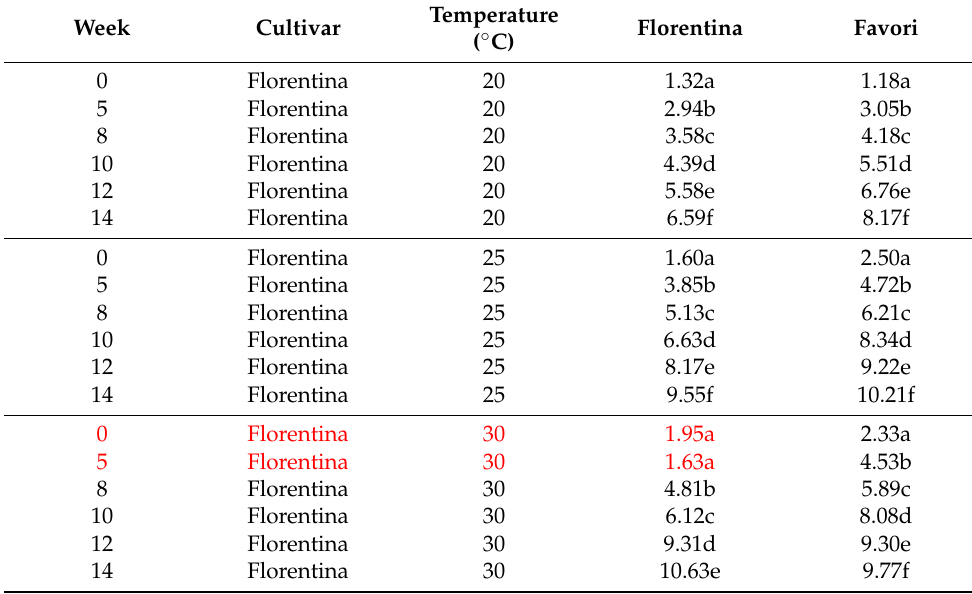
Table A2. Mixed effects linear regression model for the total number of leaf measurements taken during W0, W5, W8, W10, W12, and W14 for the three temperature treatments, 20, 25, and 30 ◦ C in SD for ‘Florentina’ and ‘Favori’. Sidak pairwise comparison shows that similar alphabet in- dicates no significant difference between weeks. The values marked in red show consecutive non-significant